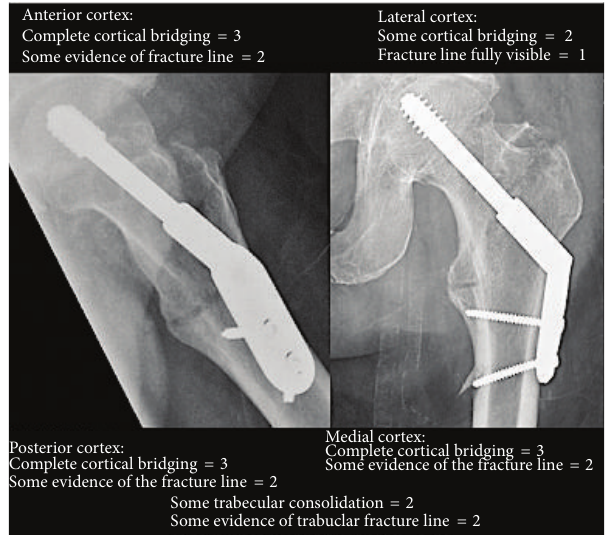
Figure 4: Assignment of the RUSH in a patient with an acute intertrochanteric fracture at 6 weeks postoperatively. The over- all score in this patient is 22. As evident, the RUSH checklist incorporates cortical and trabecular bridging and fracture line disappearance in its scoring